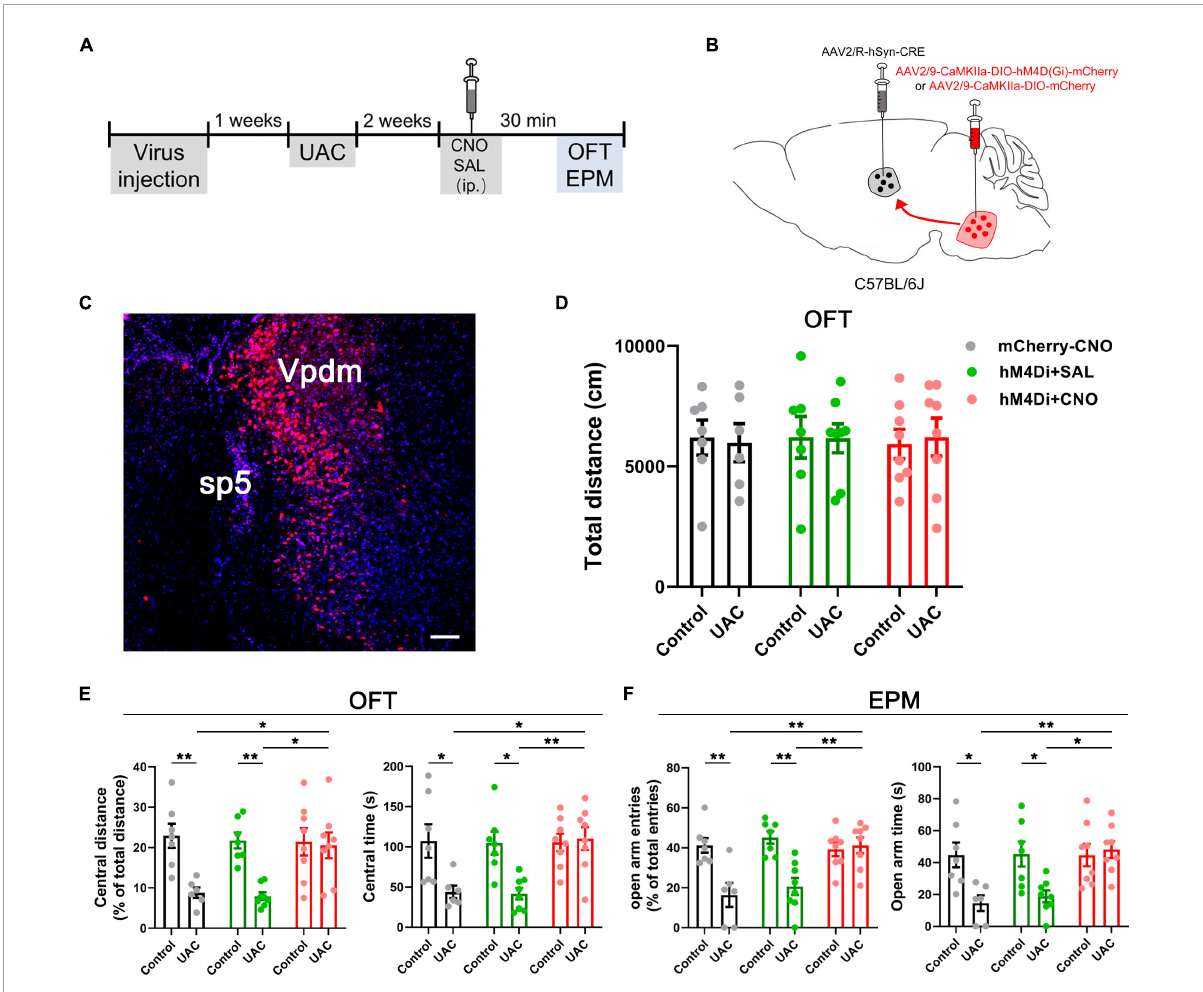
FIGURE5 Chemogenetic inhibition of the Vpdm-VPM pathway alleviated anxiety-related behaviors induced by UAC. (A) Experimental design of the chemogenetic inhibition of the Vpdm-VPM pathway to investigate anxiety-related behaviors. (B) Virus injection strategy. (C) Representative coronal section showing the expression of the hM4D (Gi)-mCherry virus in the Vpdm. Scale bar: 200 µ m. (D) The total distance traveled in the OFT was identical among the different groups. (E) The inhibition of the Vpdm-VPM pathway increased the percentage of central distance and time spent in central area in the OFT. (F) The deactivation of the Vpdm-VPM pathway increased the percentage of open arm entries and the time spent in the open arms in the EPM. Data are expressed as the mean ± SEM. Tukey’s post hoc was performed between the